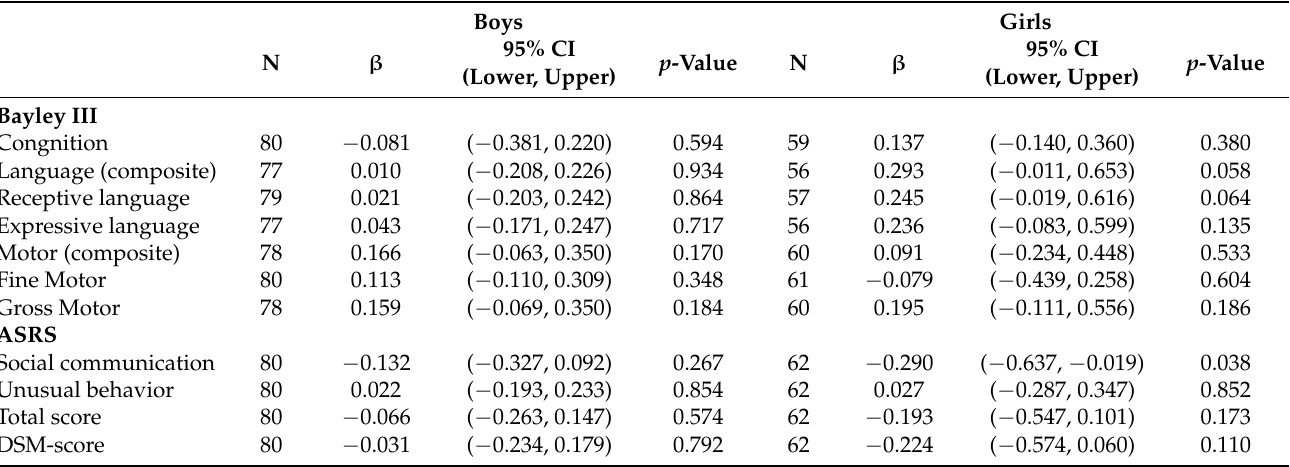
after adjusting for covariates.